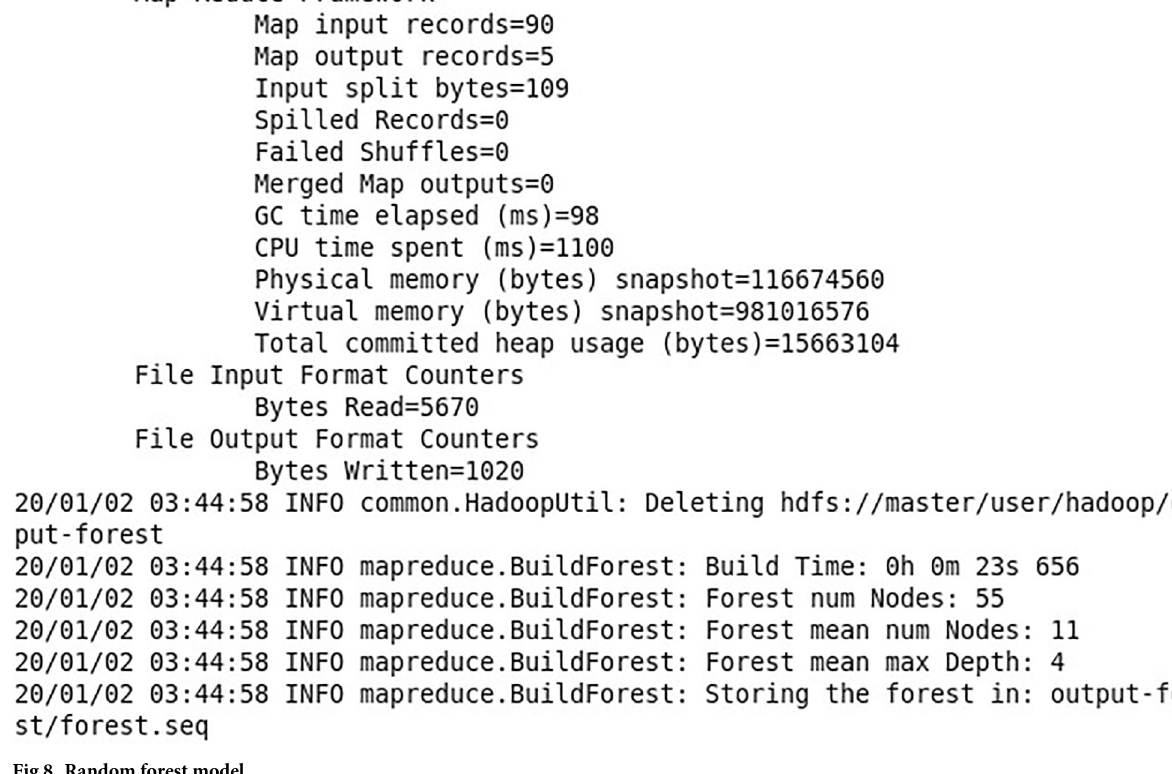
Fig 8. Random forest